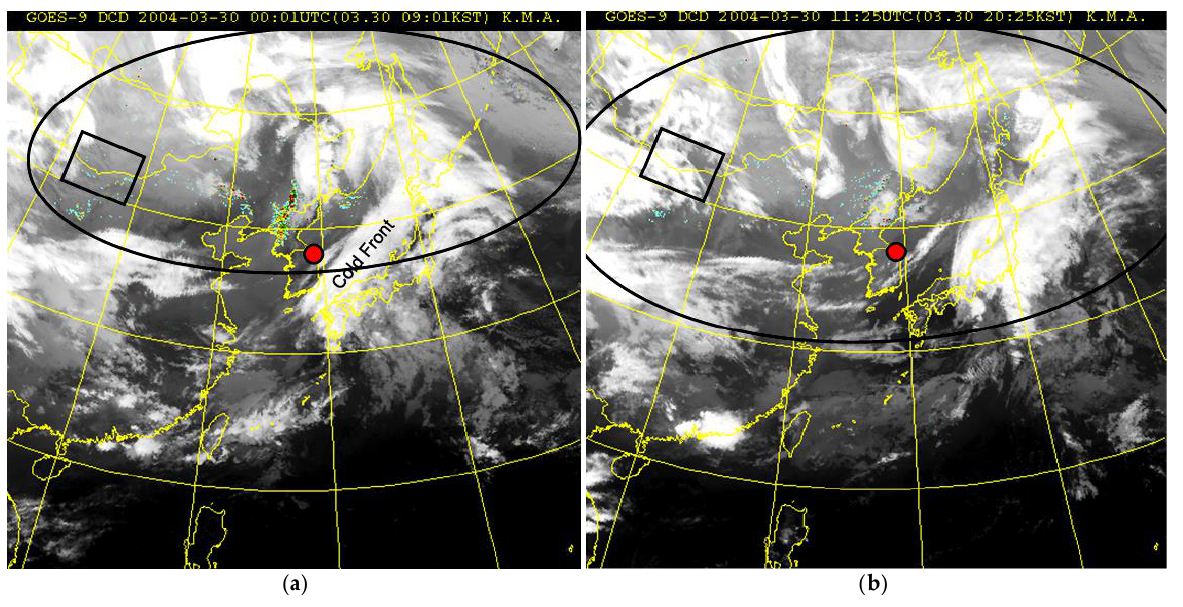
Figure 10. ( a ) GOES-9-DCD satellite picture at 09:01 LST, 30 March 2004, and ( b ) 20:25 LST. The blue color area denotes the dust originated from the Gobi Desert (a small square) and Nei-Mongo to disperse to Gangneung city (a small circle) on the Korean east coast in ( a ) and further dispersed toward the mid-China, Korean peninsula, Japan and the north-eastern Pacific Ocean.